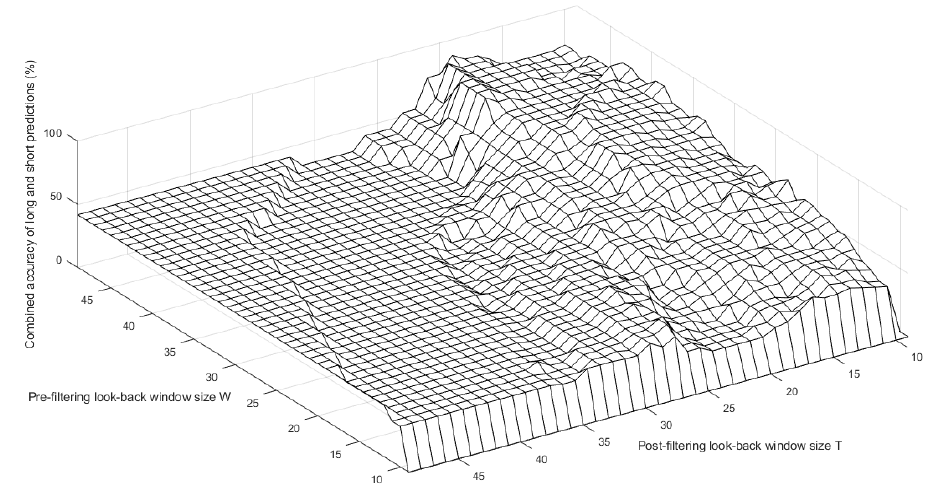
Figure 8. Surface (mesh) plot of the combined long/short predictive accuracy as a function of the pre- and post-filtering look-back window sizes W and T , respectively, for FTSE100 daily prices from 14/03/2006 to 26/02/2010.